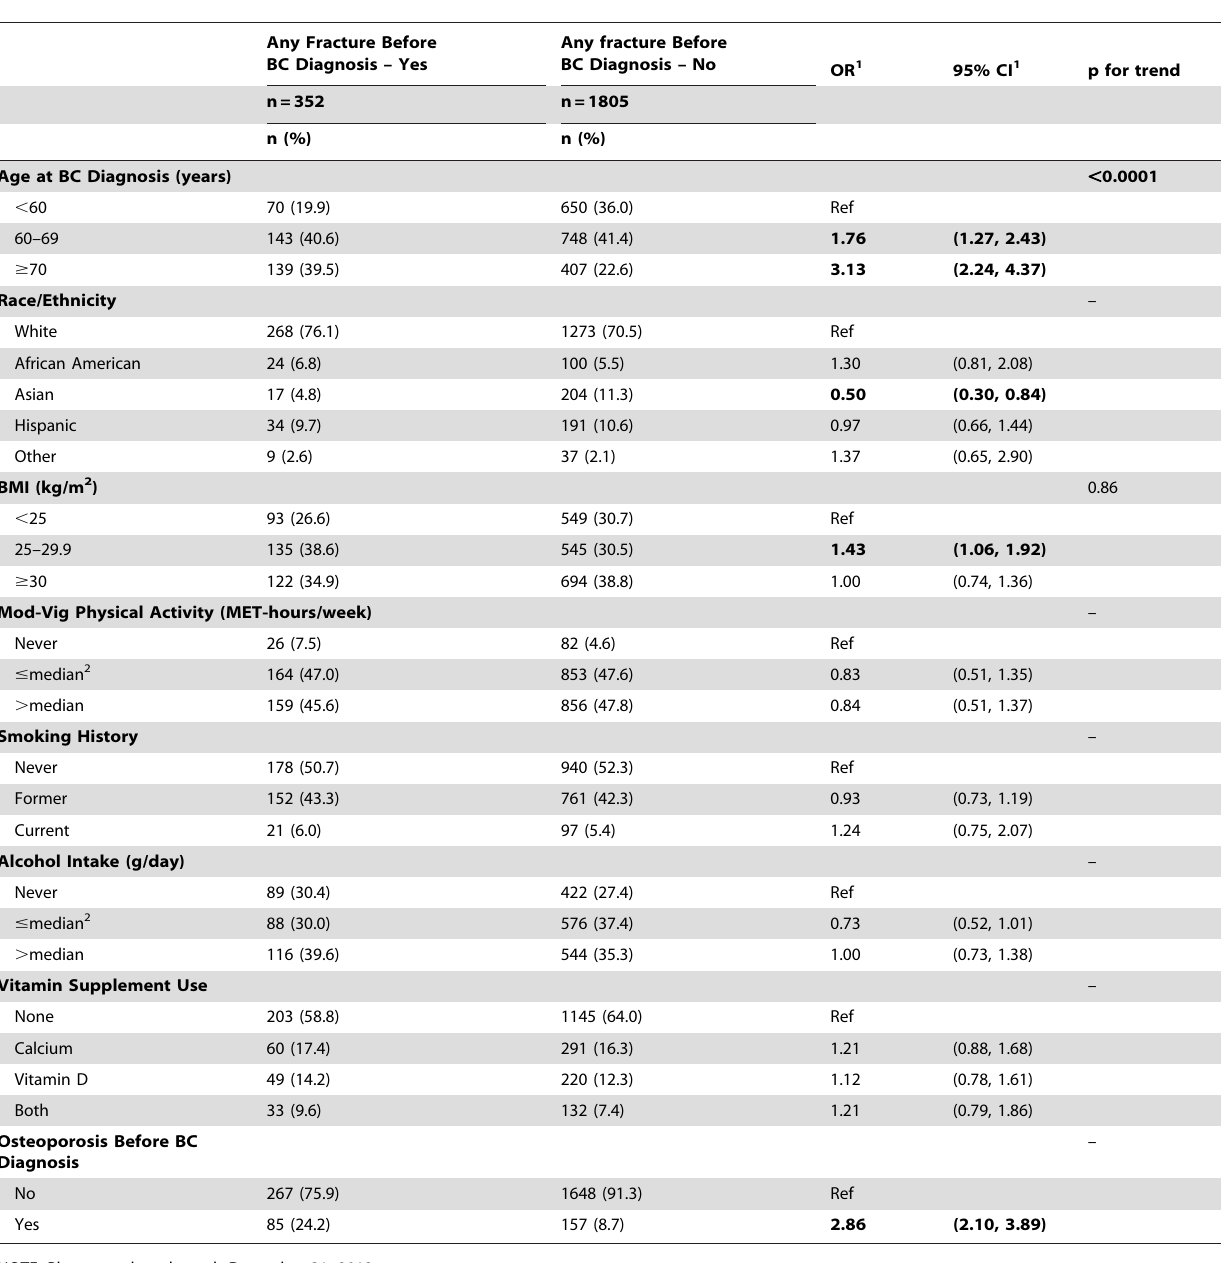
Table 3. Baseline characteristics in relation to any fracture before breast cancer (BC) diagnosis in aromatase inhibitor (AI) users.